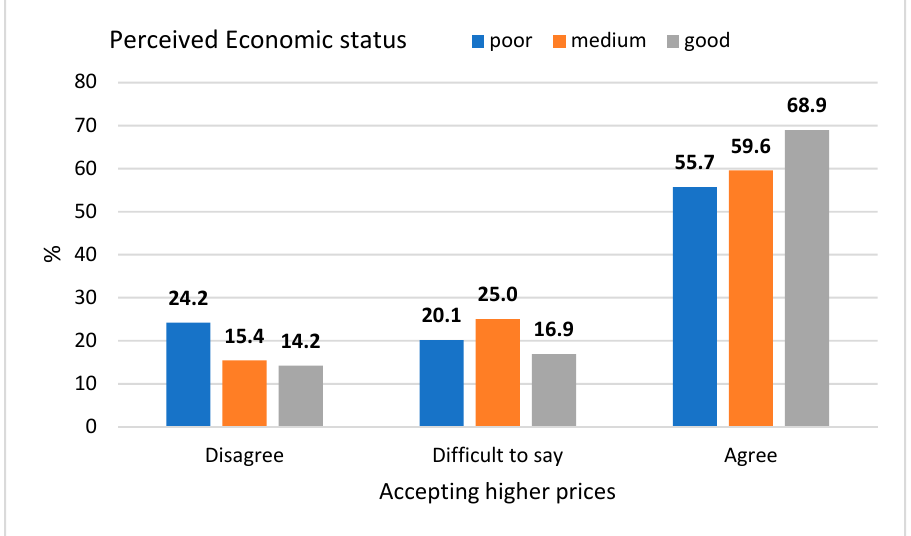
Figure 3. The percentage frequency distribution of accepting higher prices for products that do not cause environmental damage depending on the financial situation of the persons surveyed.